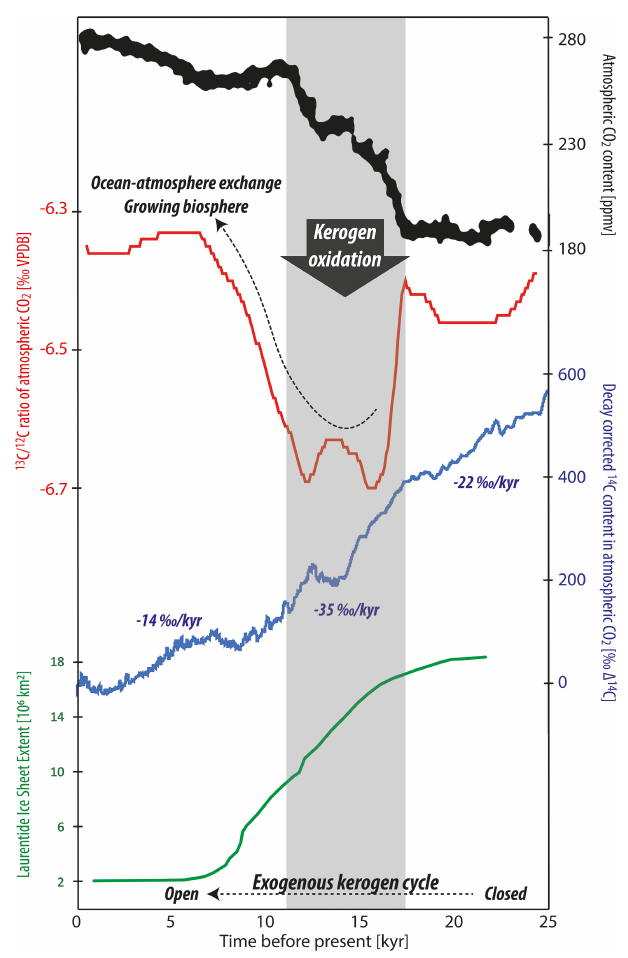
Figure 3. Evolution of atmospheric CO 2 and its carbon isotope composition starting from the Last Glacial Maximum with redrawn data from Schmitt et al. (2012) and 14 C data from Reimer et al. (2013). The area of the Laurentide Ice Sheet (including Greenland) is plotted after Dalton et al. (2020). The gray time envelope indi- cates the greatest rate of atmospheric CO 2 increase coinciding with a pronounced negative pulse in stable carbon isotope composition and accelerated decrease in radiocarbon concentration. In addition to the hypothesized role of kerogen oxidation, the superimposed ef- fects of ocean–atmosphere CO 2 exchange and a growing terrestrial biosphere must have contributed in a major way to the evolution of these